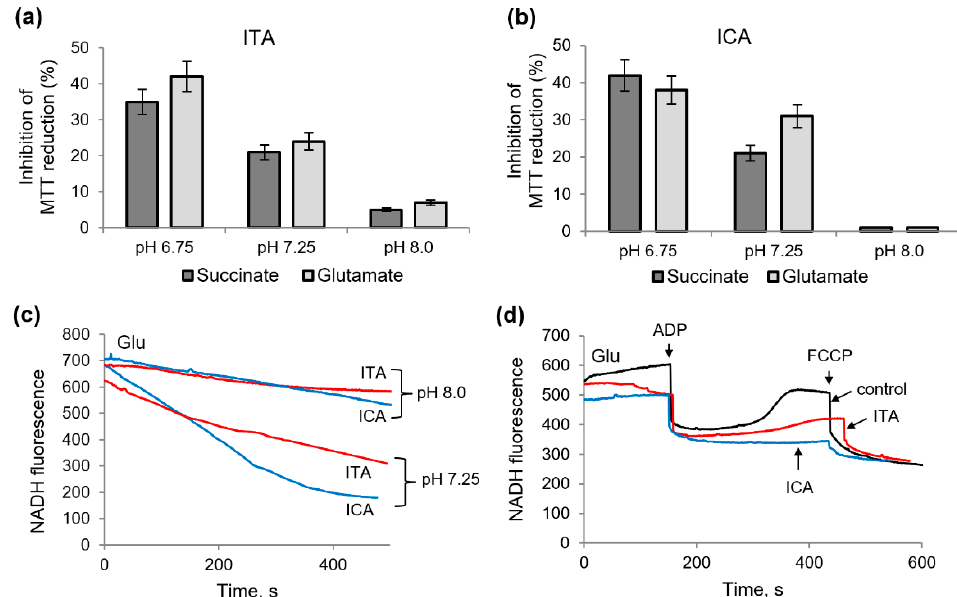
Figure 6. Elimination of the influence of itaconic and indolcaboxylic acids on the MTT reduction and NADH oxidation by the alkalization of medium. The influence of the pH of medium) on MTT reduction during succinate and glutamate oxidation in the presence of 2 mM ITA ( a ) and 250 μ M ICA ( b ); the elimination of NADH oxidation, induced by ITA and ICA, by alkalization ( c ) and changes in NAD/NADH redox states during oxidative phosphorylation in the presence of ITA and ICA ( d ) at pH 8.0; additions: 200 μ M ADP and 0.1 μ M FCCP.